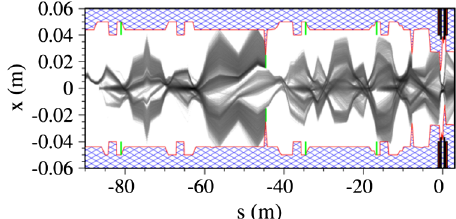
FIG. 14. Trajectories of Touschek particles lost along the ring, in green the horizontal scrapers placed at the experimental set, red line is the physical